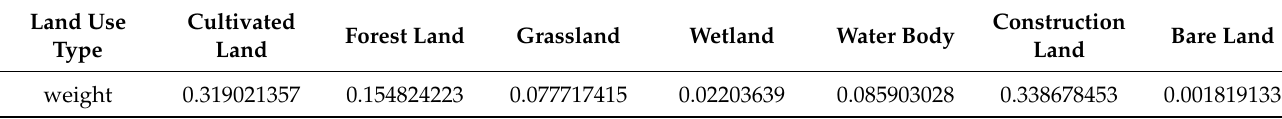
Table 3. Conversion cost matrix.